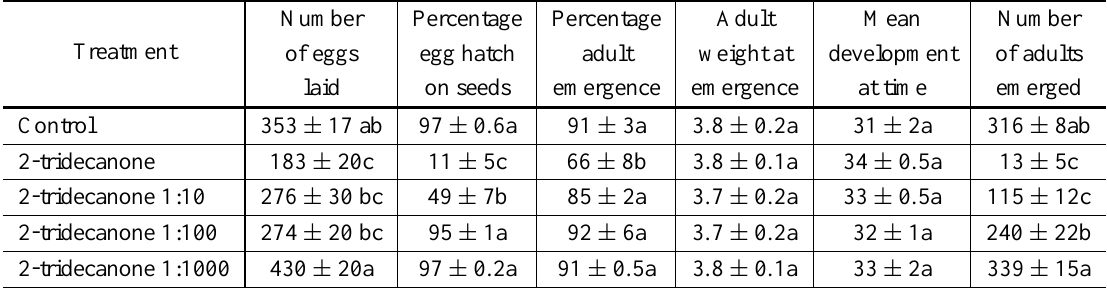
Effects of 2-tridecanone on the cowpea weevil Callosobruchus maculatusa a